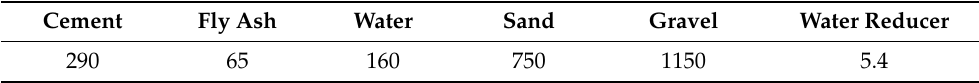
Table 2. Mix proportion (kg/m 3